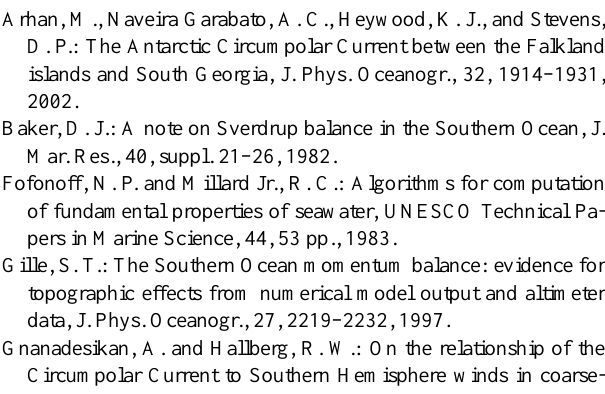
Fig. 2. The meridional distribution of the eastward baroclinic ve- locity integrated vertically from 100 to 3000m (a) along longi- tudes 150 ◦ W (curves 1, 2) and 20 ◦ W (curves 3, 4) for the pure geostrophic estimate q g with A = 0 (curves 1, 3) and for the cor- rected estimate q with b = 10 3 , A = 6 · 10 − 4 m · s − 1 (curves 2, 4); (b) along longitude 55 ◦ E for pure geostrophic estimate with A = 0 (curve 1) and for the corrected estimate q with b = 10 3 , A = 6 · 10 − 4 m · s − 1 (curve 2) and b = 10 3 , A = 10 − 3 m · s − 1 (curve